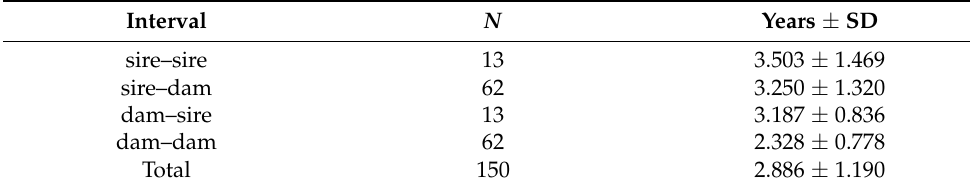
Table 2. Average generation intervals in Nero Lucano pigs.